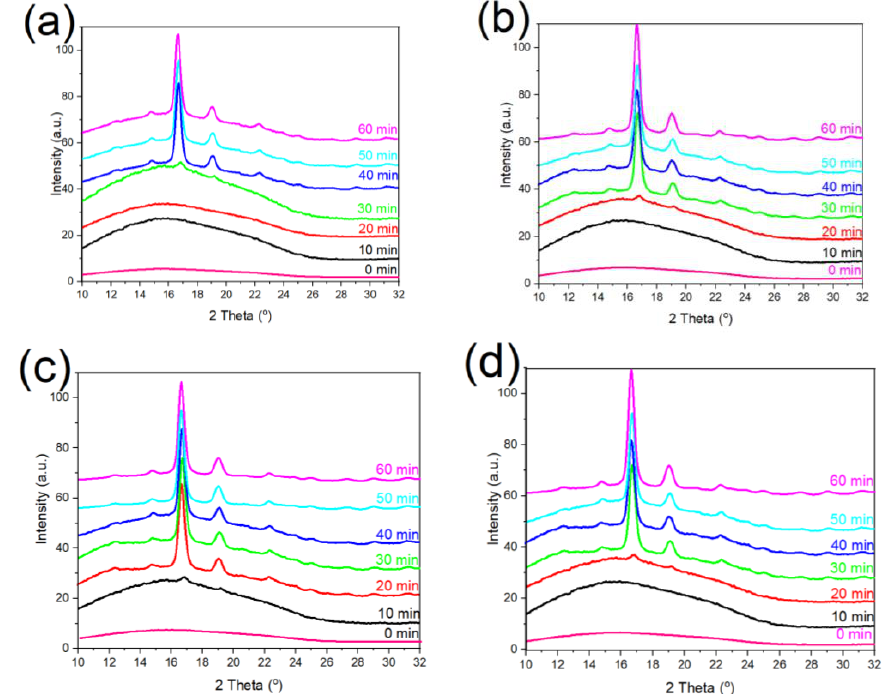
Figure 4. The WAXS analysis of ( a ) neat PLA, ( b ) PLA/g-SNC (3 wt%), ( c ) PLA/g-SNC (5 wt%),